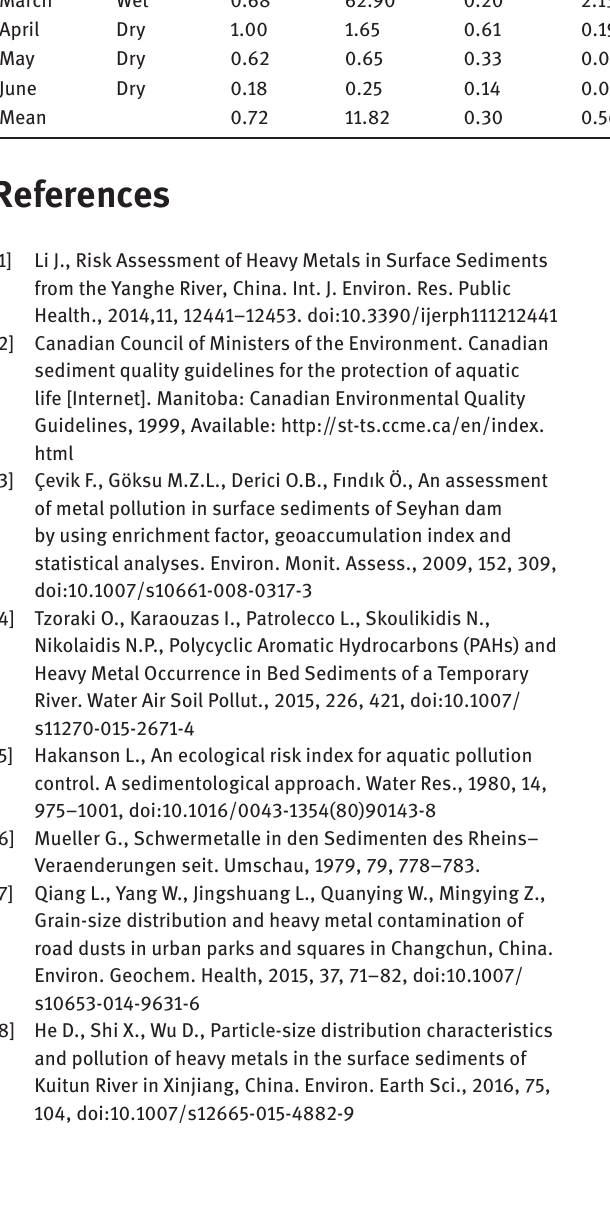
Table 4: Monthly average E i